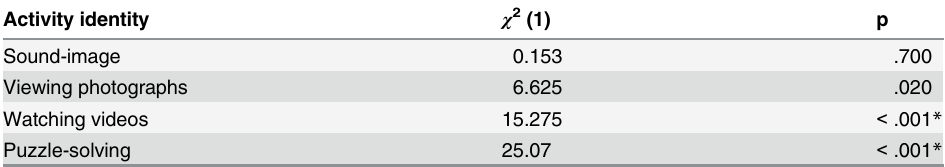
Table 1. Effects of age on activity reportedly liked.